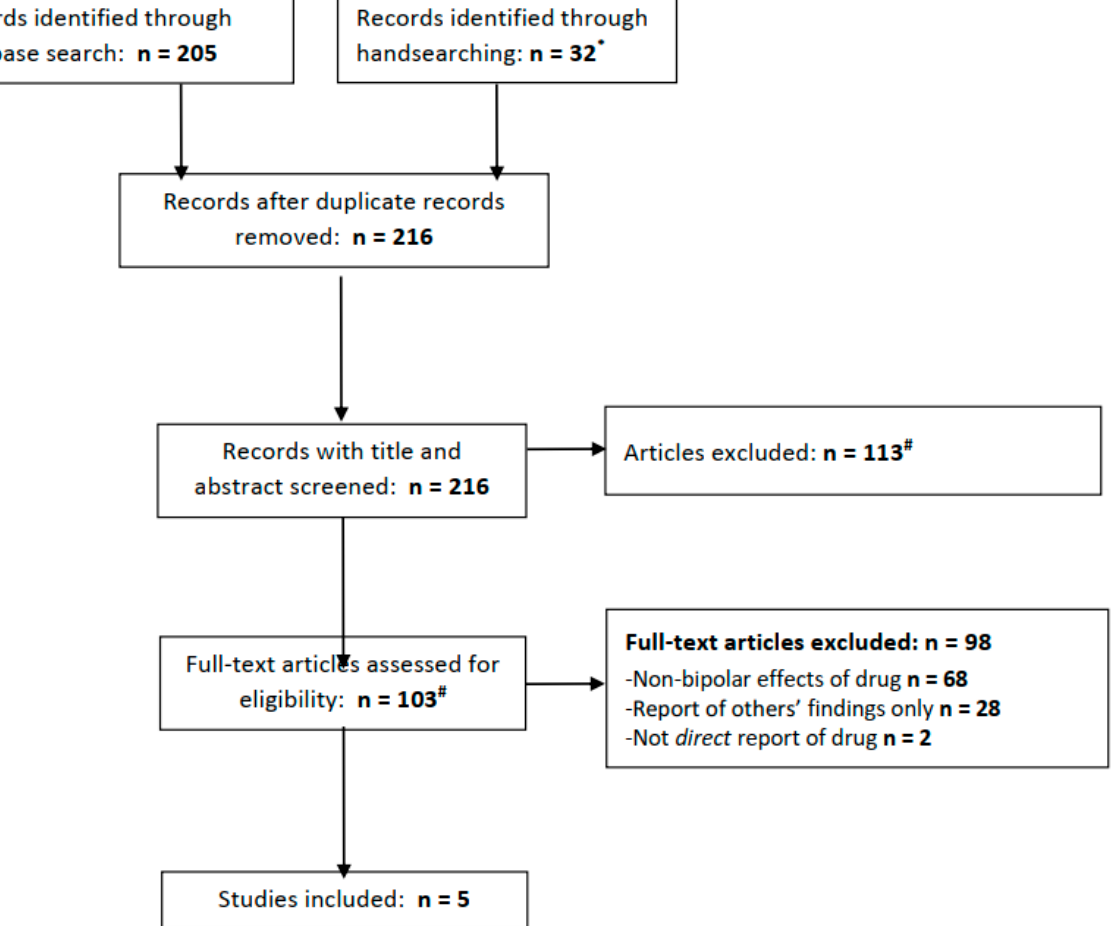
Figure 1. PRISMA flow diagram for included studies. * We searched clinicaltrials.gov for acetazo- lamide + bipolar (0 results), mania (0 results), depression (0 results), or more broadly, psychiatric disorder (7 results, of which 1 is ongoing for schizophrenia, 4 excluded people with psychiatric diagnoses and 2 did not mention relevant population or outcomes.) # Three full texts not found from any